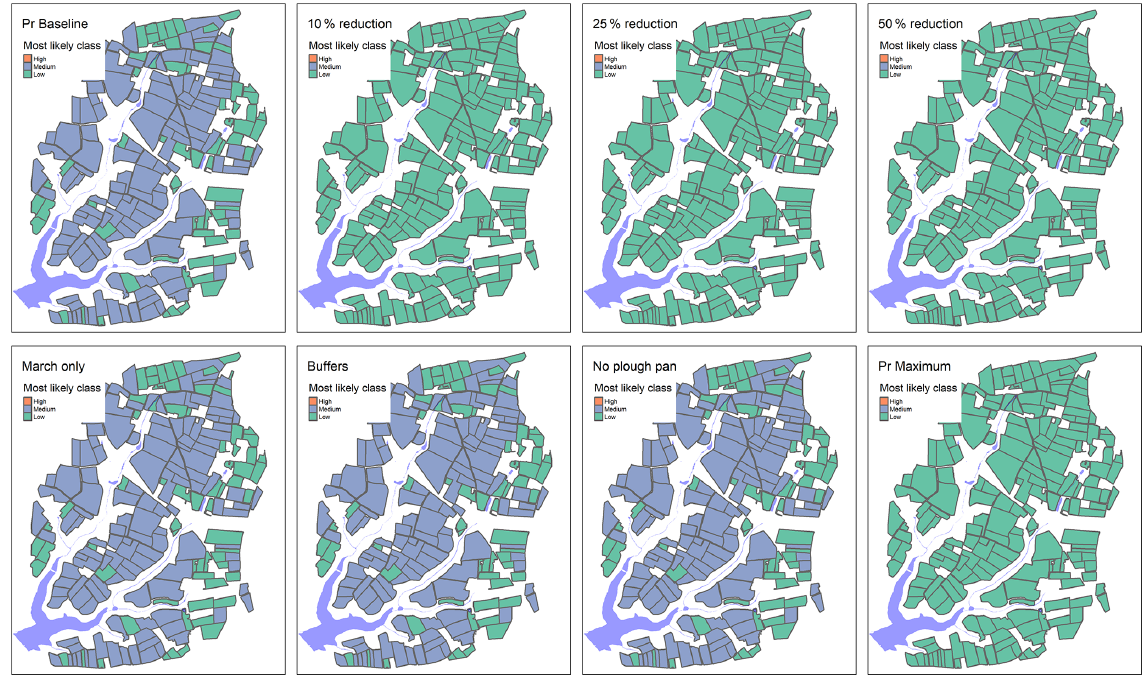
Figure 9. Example output showing the most likely groundwater leaching risk class for each field for prosulfocarb under current (baseline) application practices; with a 10%, 25%, or 50% reduction in application; with a time shift of application to March; with additional field buffers; with no plough pan; and with a combination of all available mitigation measures (shifting application to March, a 50% reduction in application rates, buffers, and no soil